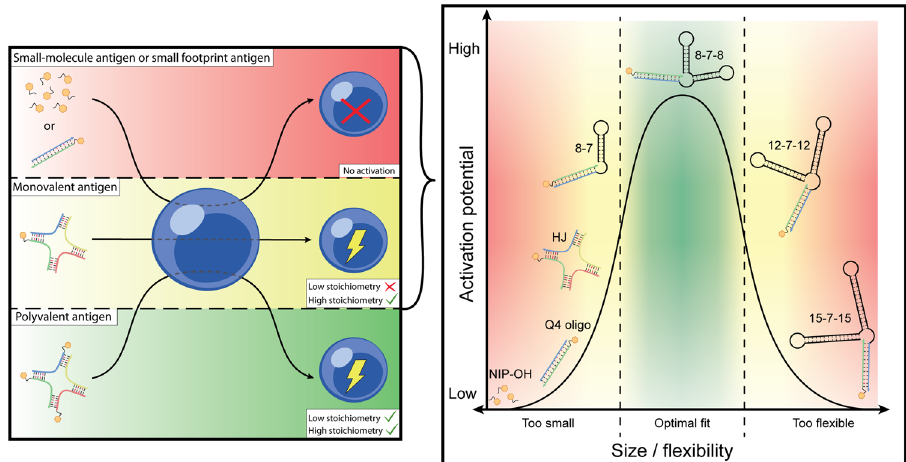
Fig. 8 | Schematic representation of central fi ndings. Left: Polyvalent antigen inducesrobustactivationatbothlowandhighstoichiometry,whereasmonovalent antigen is only active at high stoichiometry, and small-molecule or small footprint monovalent antigen has no activity whatsoever. Right: The role of footprint in